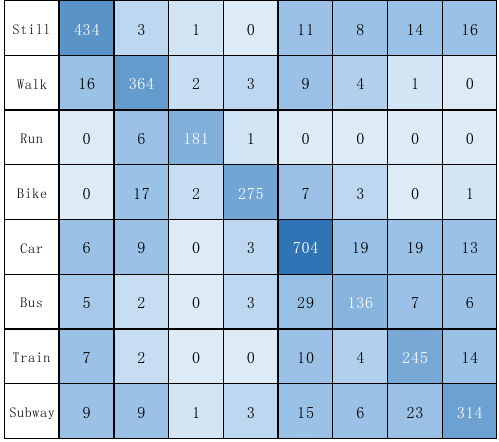
Figure 12. The confusion matrix of DFTrans on the HTC dataset.